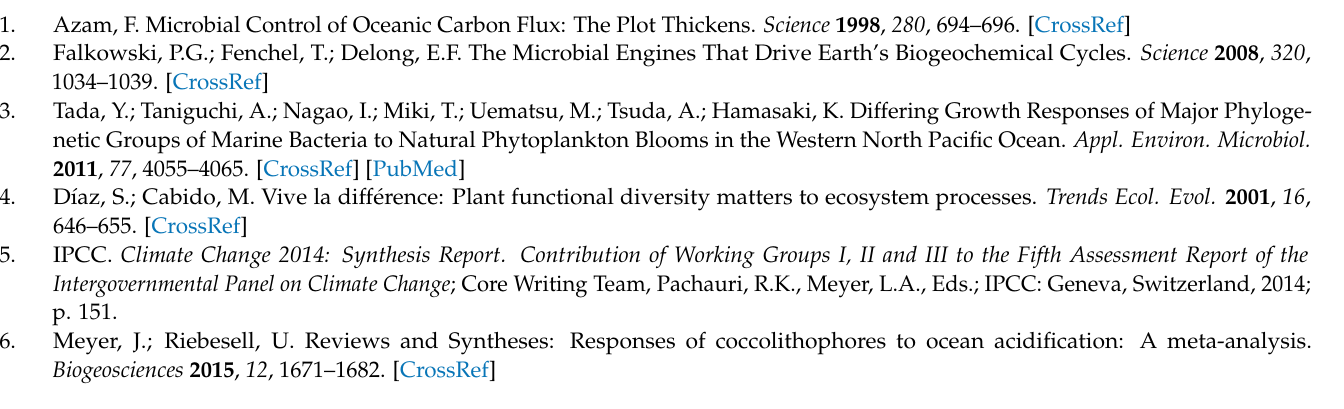
Table S10: Functional genome profiling of Idiomarina abyssalis PhyBa_CO2_1 genome according to COG and Pfam